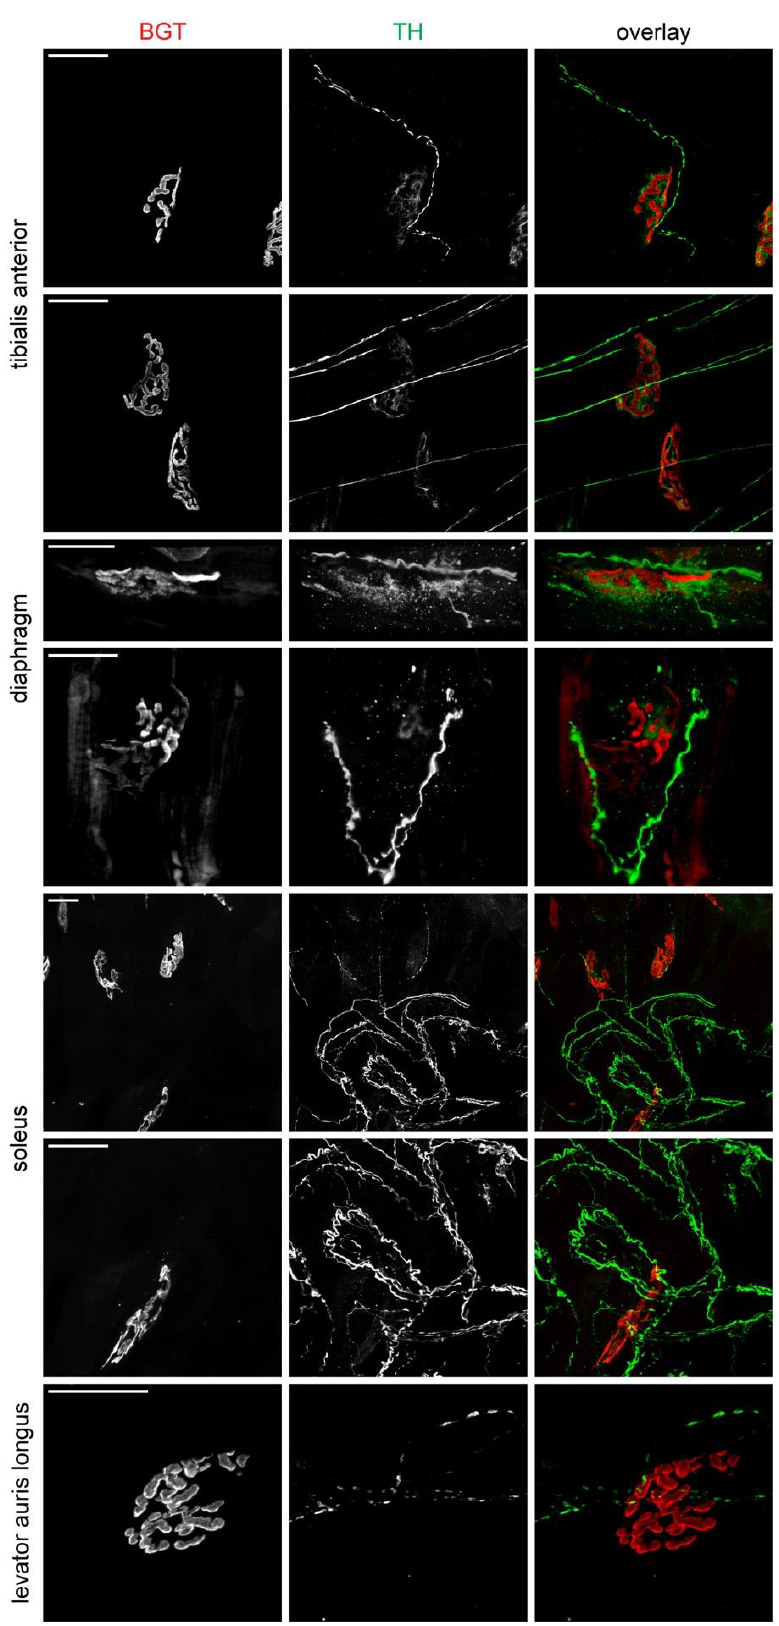
Figure 2. Sympathetic innervation approaches NMJs in various skeletal muscles. Diaphragm muscle was from P30, tibialis anterior, soleus, and levator auris longus muscles were from P90 wildtype mice. Except for diaphragm muscle, which was prepared as a whole mount, fiber bundles were teased from these muscles as indicated and stained for NMJs (BGT, red in overlays) and sympathetic neurons (TH, green in overlays). Images show maximum z-projections of confocal image stacks. Scalebars, 20 µm.